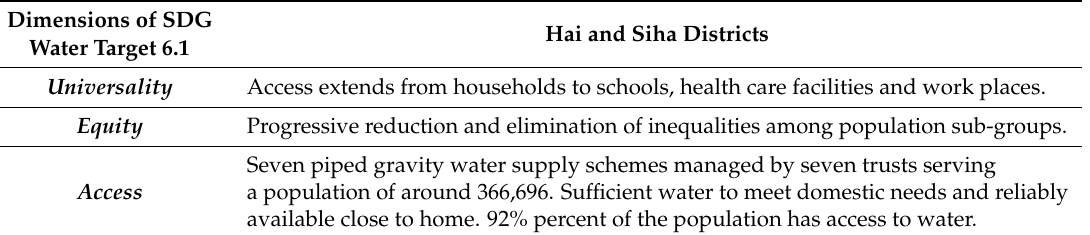
Table 4. Sustainability dimensions ascribed in SDG water target 6.1 on drinking water [34]. Dimensions of